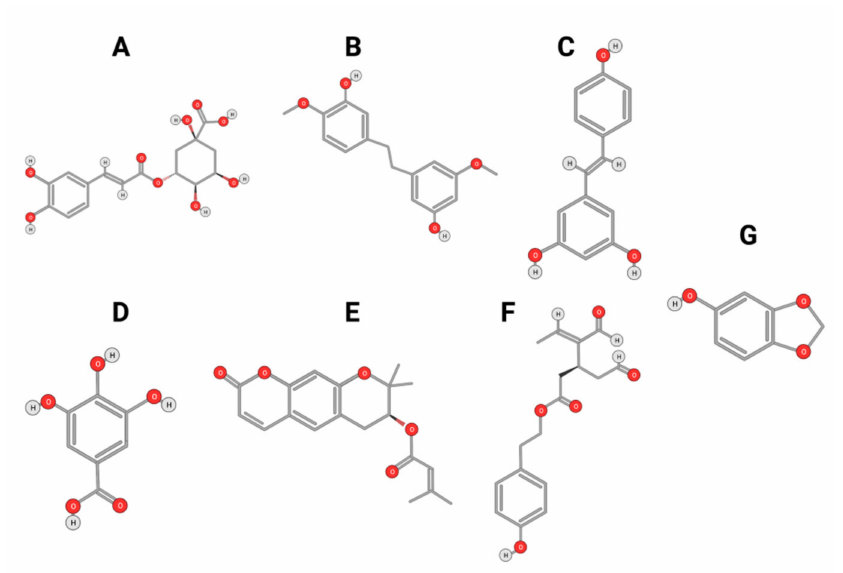
Figure 9. Chlorogenic Acid ( A ); Gigantol ( B ); Resveratrol ( C ); Gallic Acid ( D ); Decursin ( E ); Oleocan- thal ( F ); and Sesamol ( G